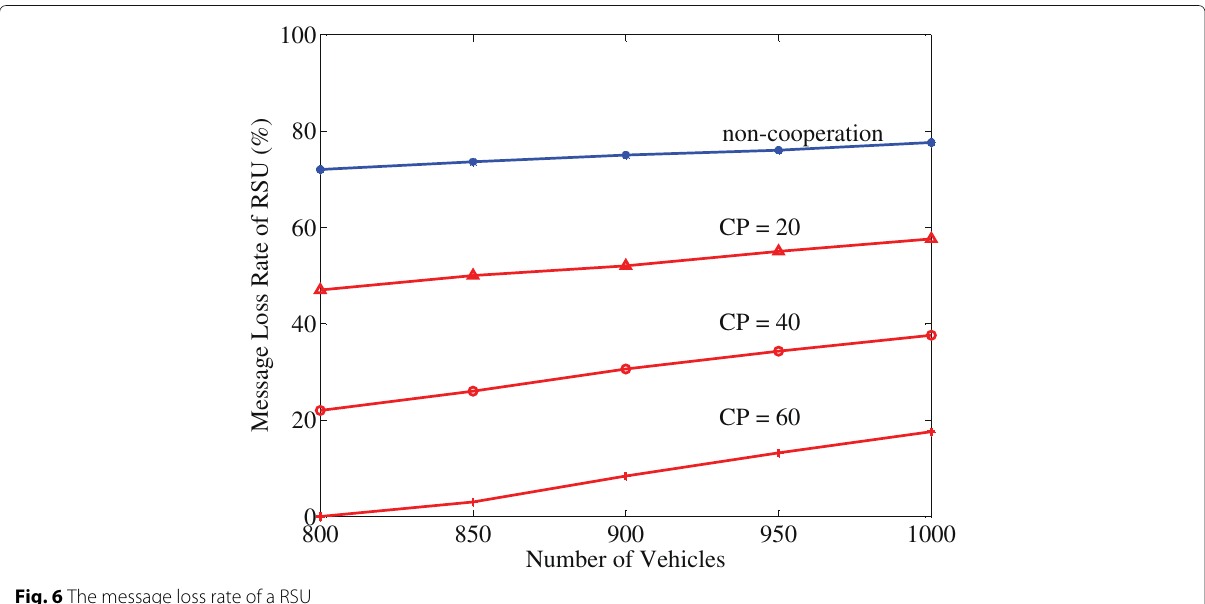
Fig. 6 The message loss rate of a